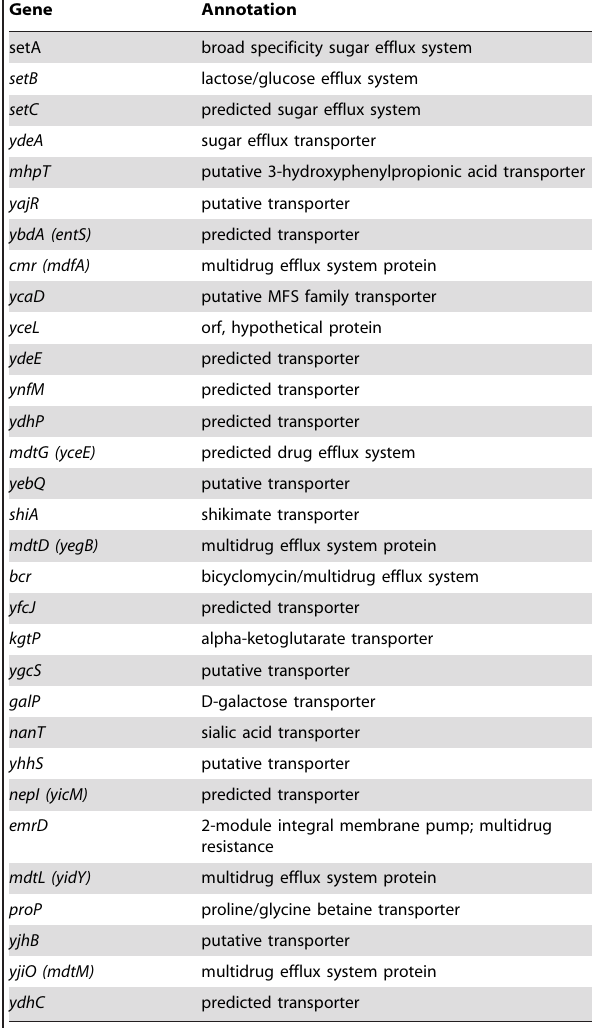
Table 1. List of